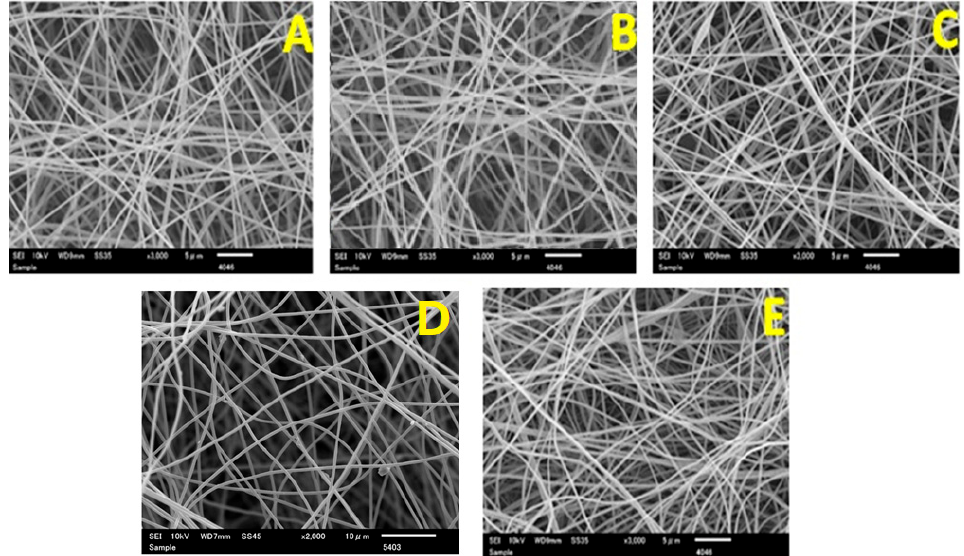
Figure 1. Surface morphology of prepared electrospun nanofibers: ( A ) pure PAN, ( B ) 0.5% VB PAN, ( C ) 1% VB PAN, ( D ) 1.5% VB PAN, and ( E ) 2% VB PAN.